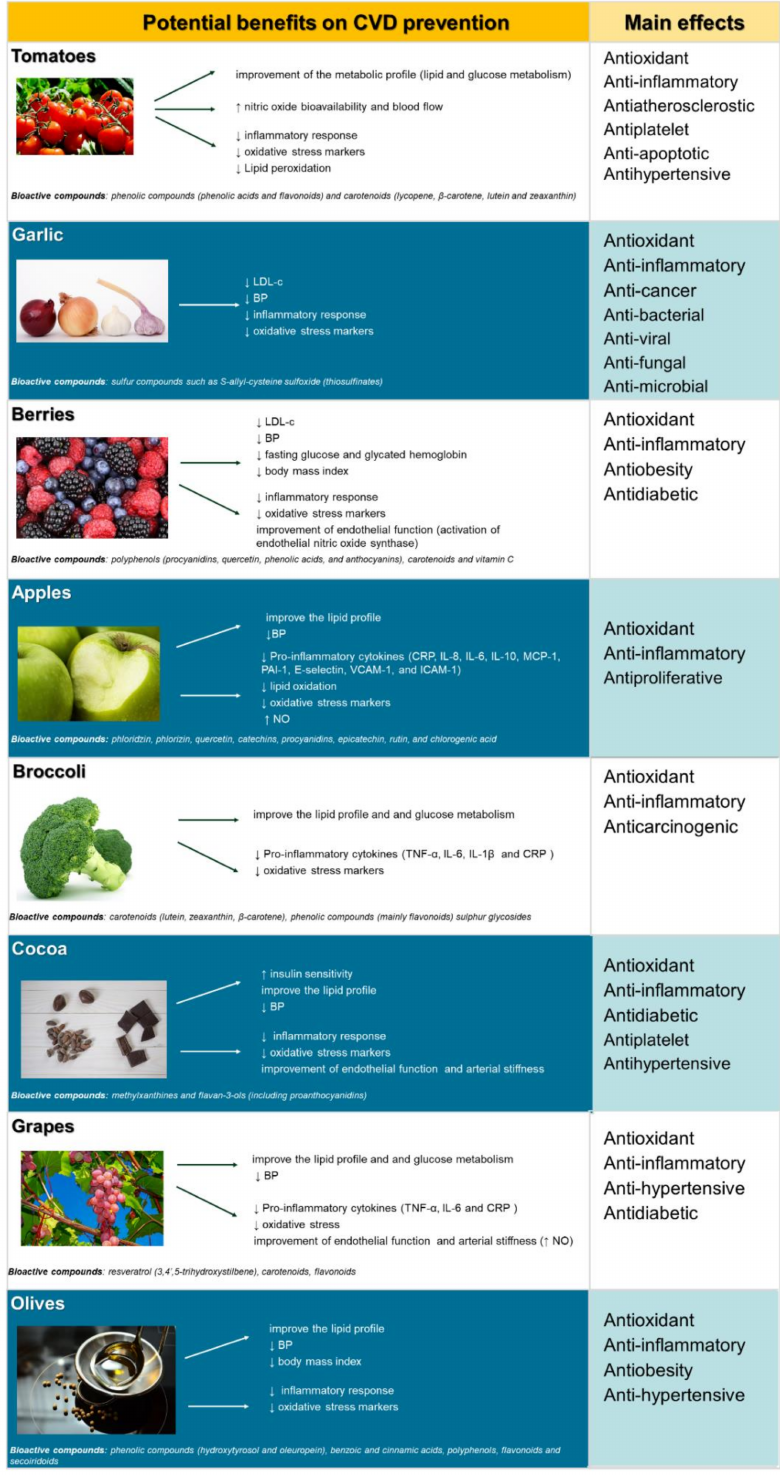
Figure 1. Summary of the potential health benefits of the main bioactive compounds contained in fruits and vegetables mentioned in this